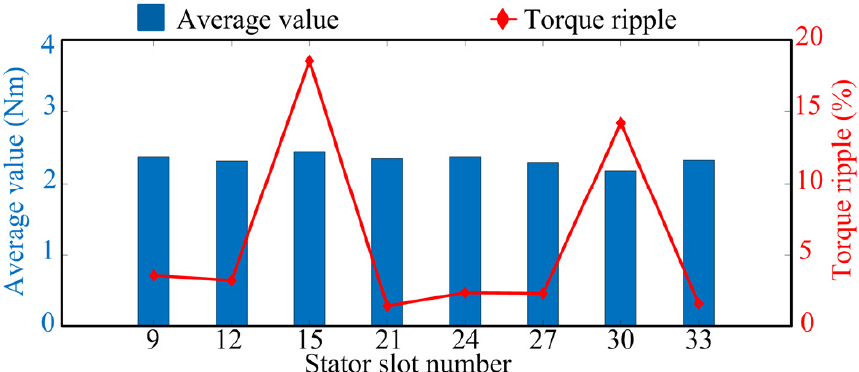
Figure 6. The average value and torque ripple of electromagnetic torque under different numbers of stator slots when the number of rotor poles is 8.